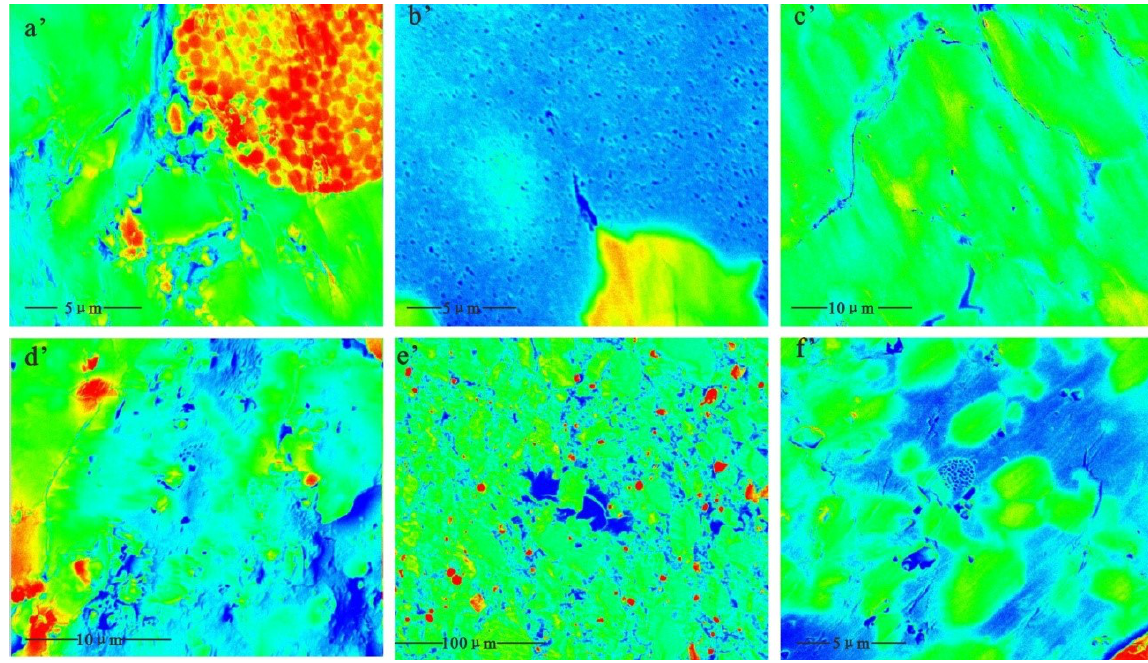
Figure 6: Pseudo-color pore feature enhancement characterization results